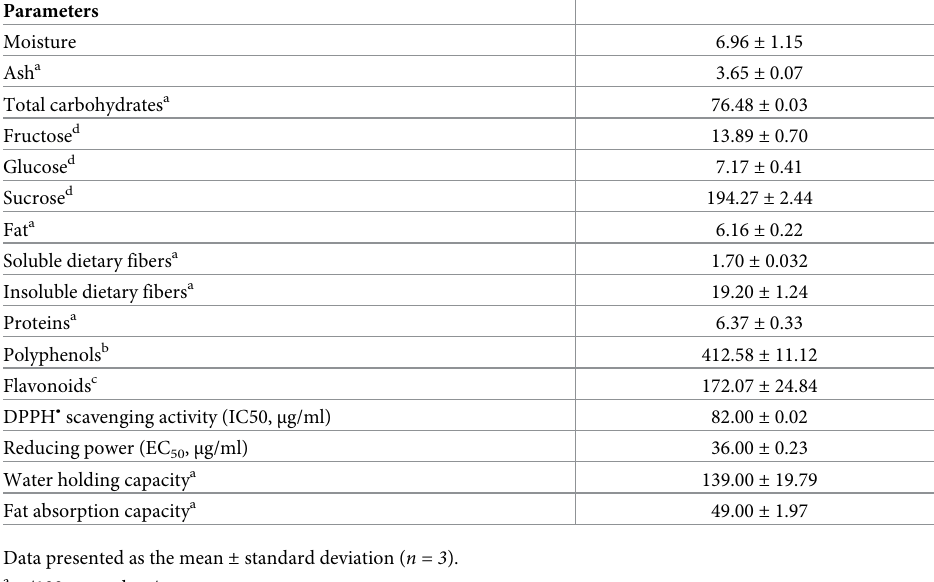
Table 1. Chemical and functional characteristics of jujube